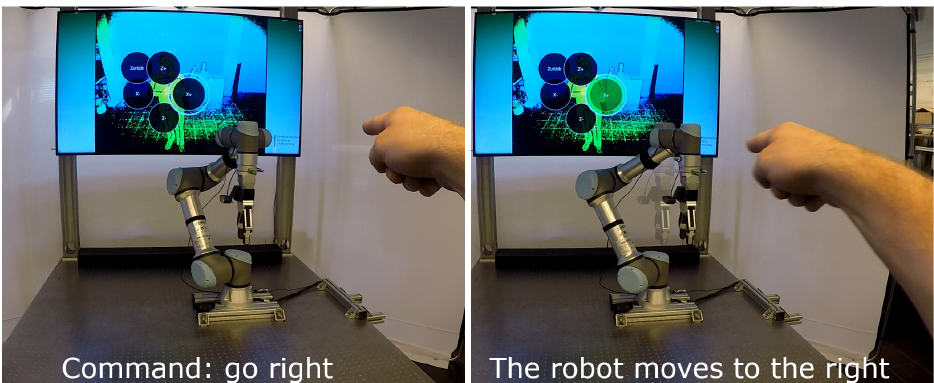
Figure 7. Augmented virtual menu for user